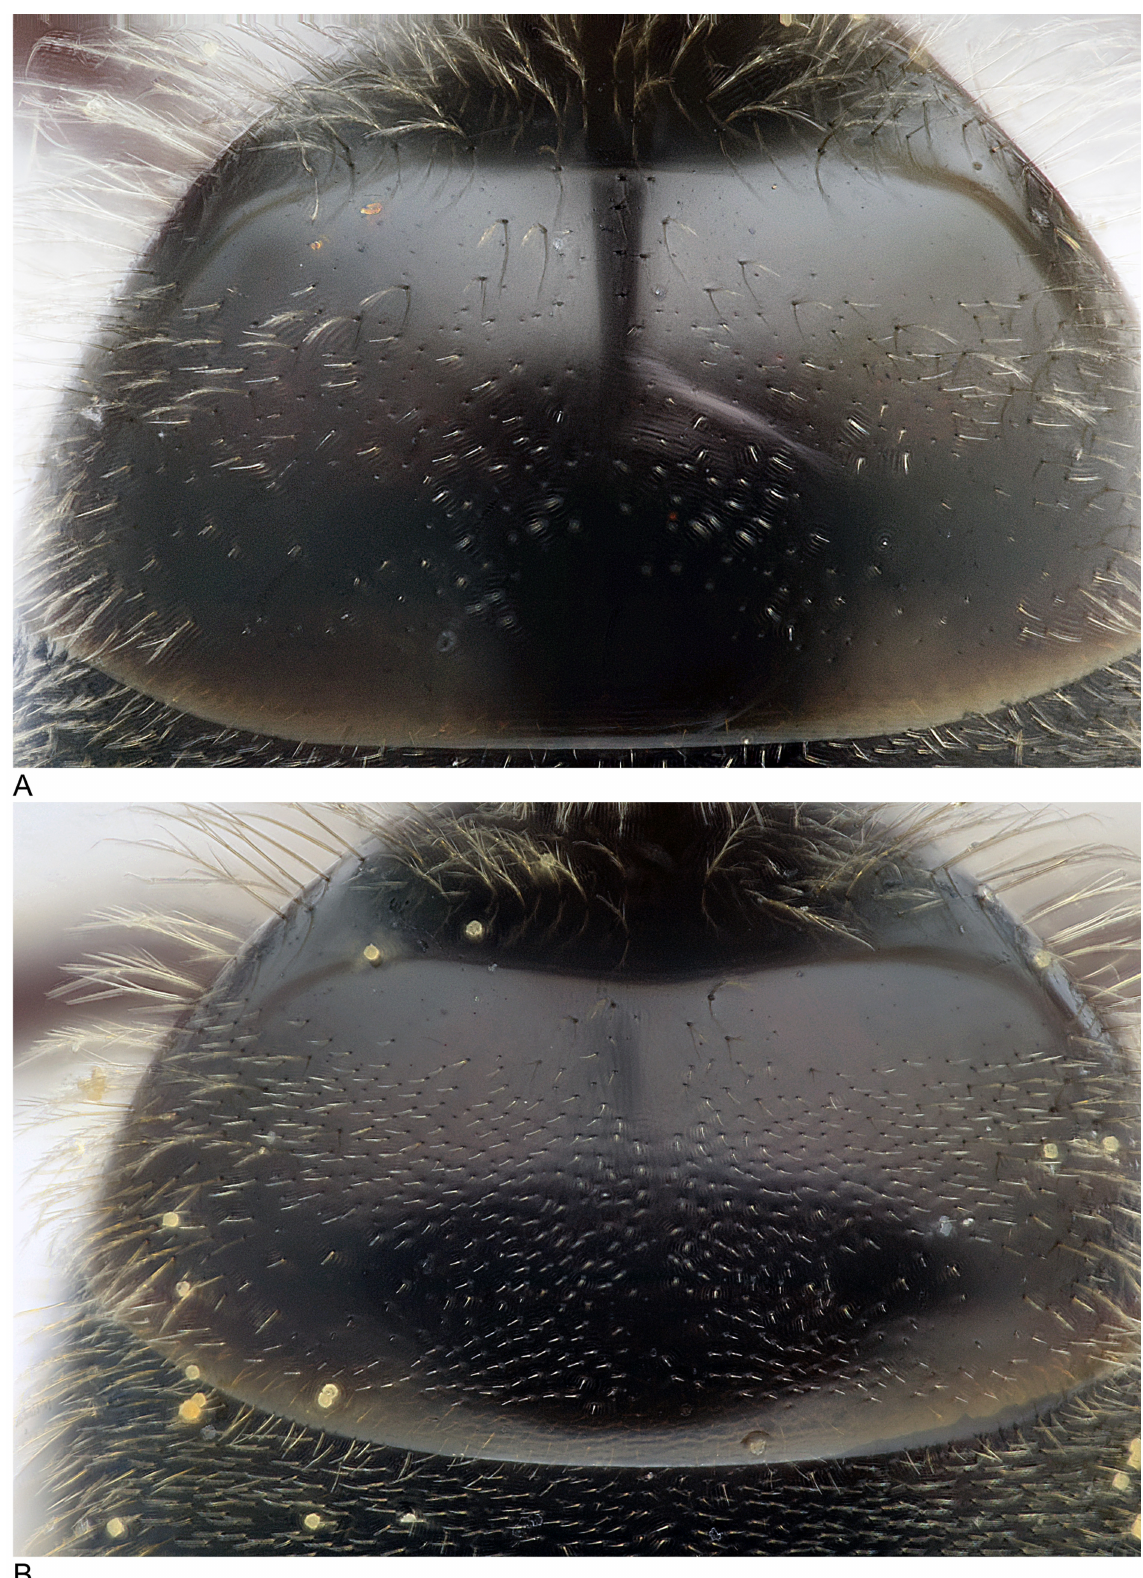
Fig. 18. Punctation of the first tergum of females. A . Lasioglossum medinai (Vachal, 1895) (France: Uchaux). B . L. villosulum (Kirby, 1802) (France: